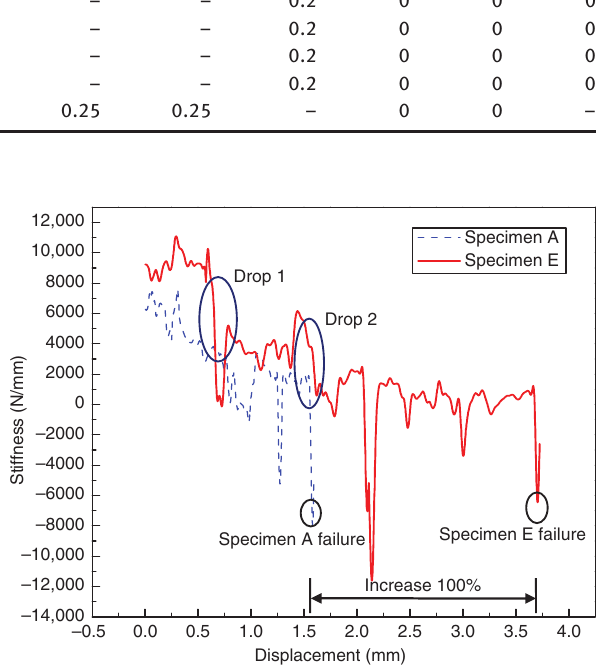
Figure 8: Stiffness spectrum comparison between specimen A and specimen E.